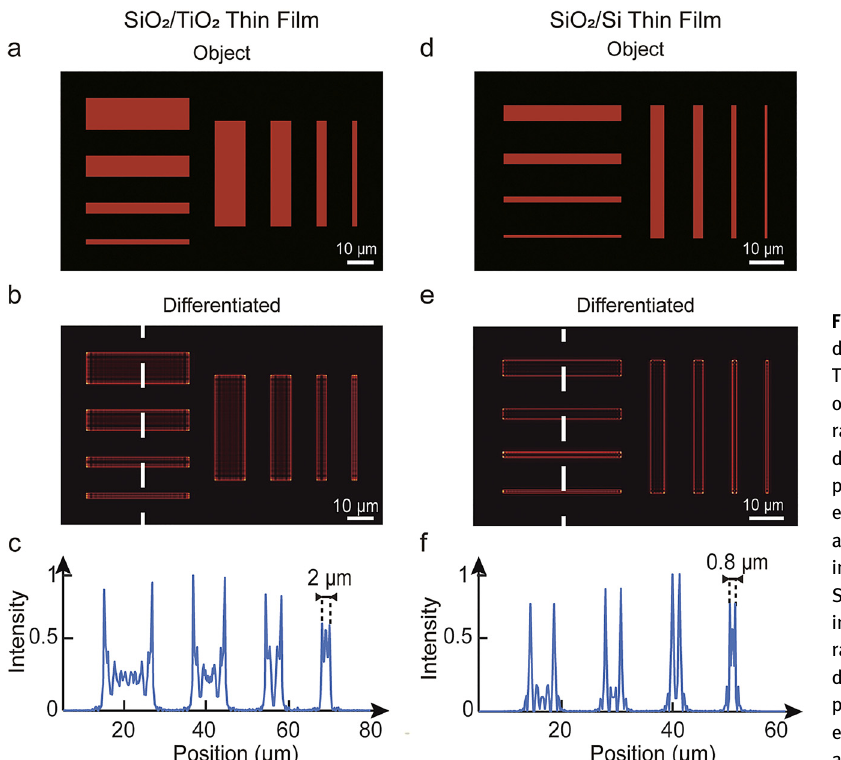
Figure 3: (a) – (c) Simulated image differentiation performance of the SiO 2 / TiO 2 design.(a)Imageoftheassumedinput object made of rectangles with width ranging from 12 to 2 μ m. (b) Simulated differentiated image of the rectangular patterns. (c) The vertical-cut of the differ- entiated image along the white dashed line as speci fi ed in panel (b). (d) – (f) Simulated image differentiation performance of the SiO 2 /Si design. (d) Image of the assumed input object made of rectangles with width ranging from 4.8 to 0.8 μ m. (e) Simulated differentiated image of the rectangular patterns. (f) The vertical-cut of the differ- entiated image along the white dashed line as speci fi ed in panel